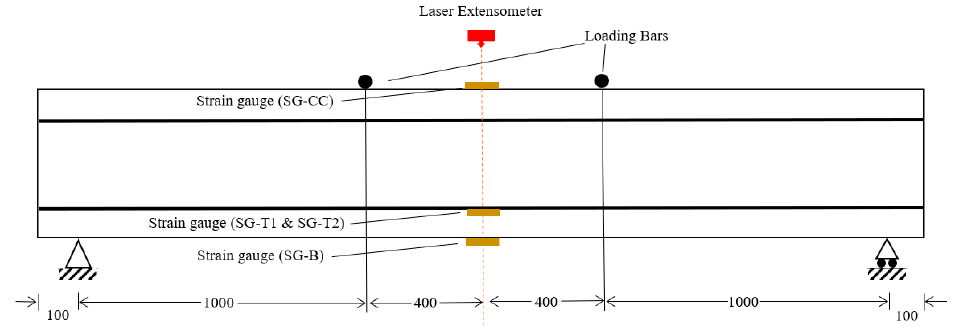
Figure 4. Schematic diagram of the test setup.